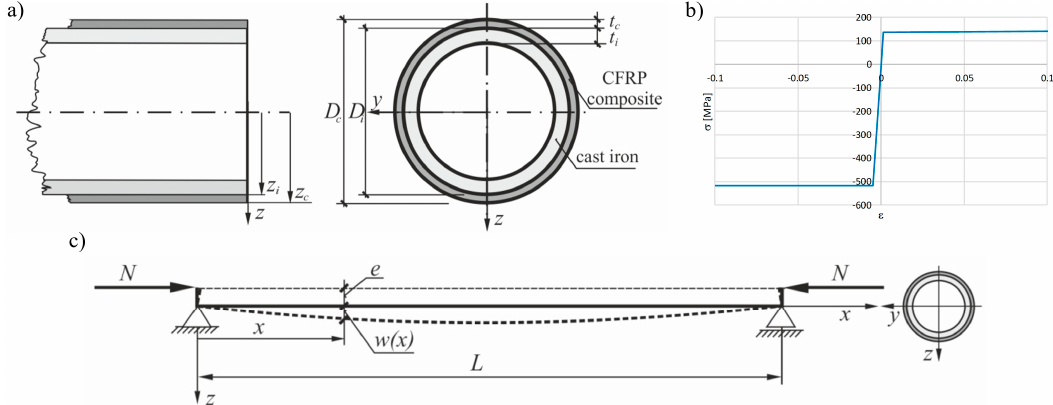
Figure 2. The beam column geometrical and mechanical data: ( a ) Tubular cross section; ( b ) adopted, simplified characteristics for cast iron; ( c ) loading scheme.